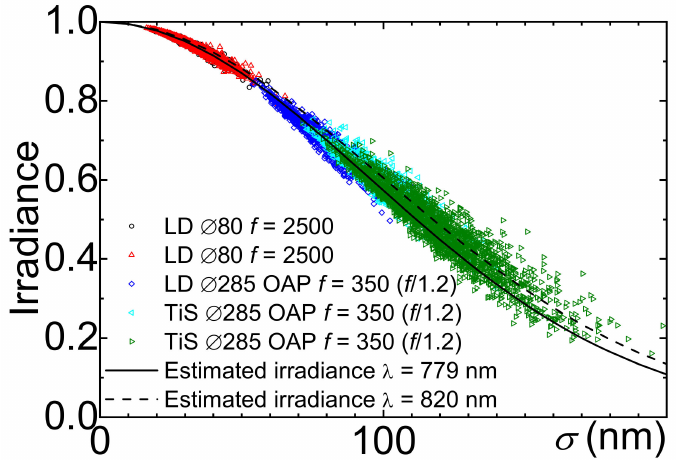
Figure 4. Dependencies of the normalized irradiance calculated from the measured wavefront on the root mean square (RMS) wavefront distortion σ . The data are obtained with two lasers: Laser Diode (LD), λ = 779 nm and Ti:sapphire (TiS), λ = 820 nm, beam diameters of 80 and 285 mm, focused with an f = 2500 mm lens and f = 350 mm ( f /1.2) Off-Axis Parabolic (OAP) mirror. The solid and dashed lines show the estimates using (1) with η =